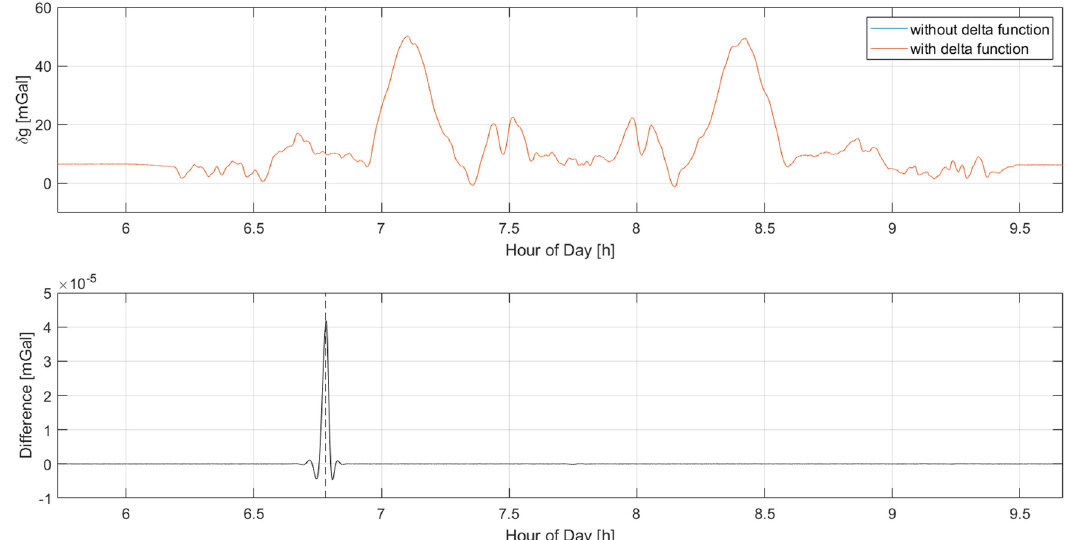
Figure 2: Illustration of vertical gravity estimates with and without applying a delta function of 1 mGal amplitude to the vertical channel of acceleration. The dashed line illustrates where the delta function was applied. ( Top ) Gravity disturbance estimates with and without applying a delta function ( di ff erence not visible – red curve is on top of the blue curve ) . ( Bottom ) Di ff erence between the two estimated gravity pro fi